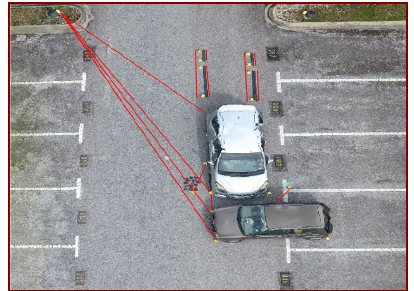
Figure 10. Measurement taken by Police Investigator The speed of the vehicles can be known by the length of the tyre on the road. The longer the tyre effect the higher the vehicle speed, as the vehicle takes time to stop and causes marks on the road. This study analyses the behaviour of the results with a class frequency table. A class frequency table was done with data from UAV measurements with 33 samples obtained from POI and waypoint techniques. For POI results, Figure 11a shows that the data is skewed to the left where the highest values of class relative frequency was in the range of 0.583 to 3.803 and the lowest values of class relative frequency was in the range of 10.243 to 11.850. For waypoint results, Figure 11b shows the data was skewed to the left where the highest values of class relative frequency was in the range of 0.526 to 3.774 and the lowest values of class relative frequency was in the range of 10.270 to